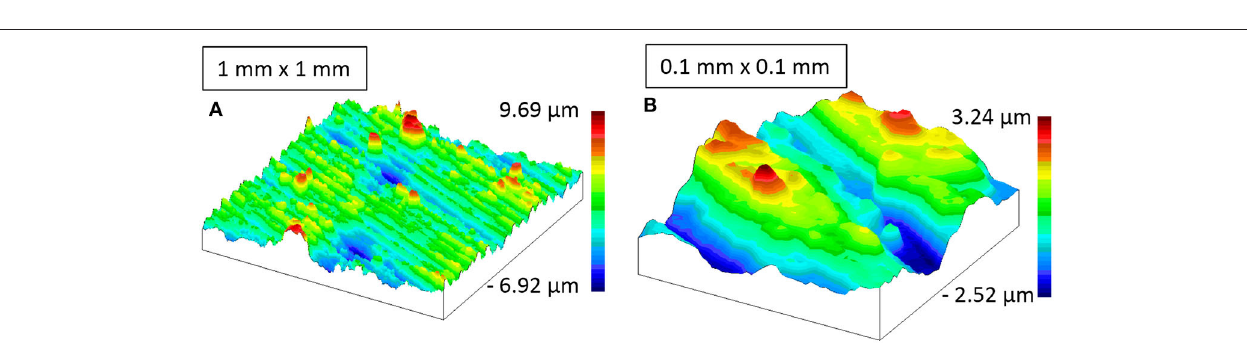
FIGURE 7 | Topography of a milled surface (Sdq = 0.231; Sdr = 2.557%). (A) 1mm by 1mm measuring area. (B) 0.1mm by 0.1mm measuring area.